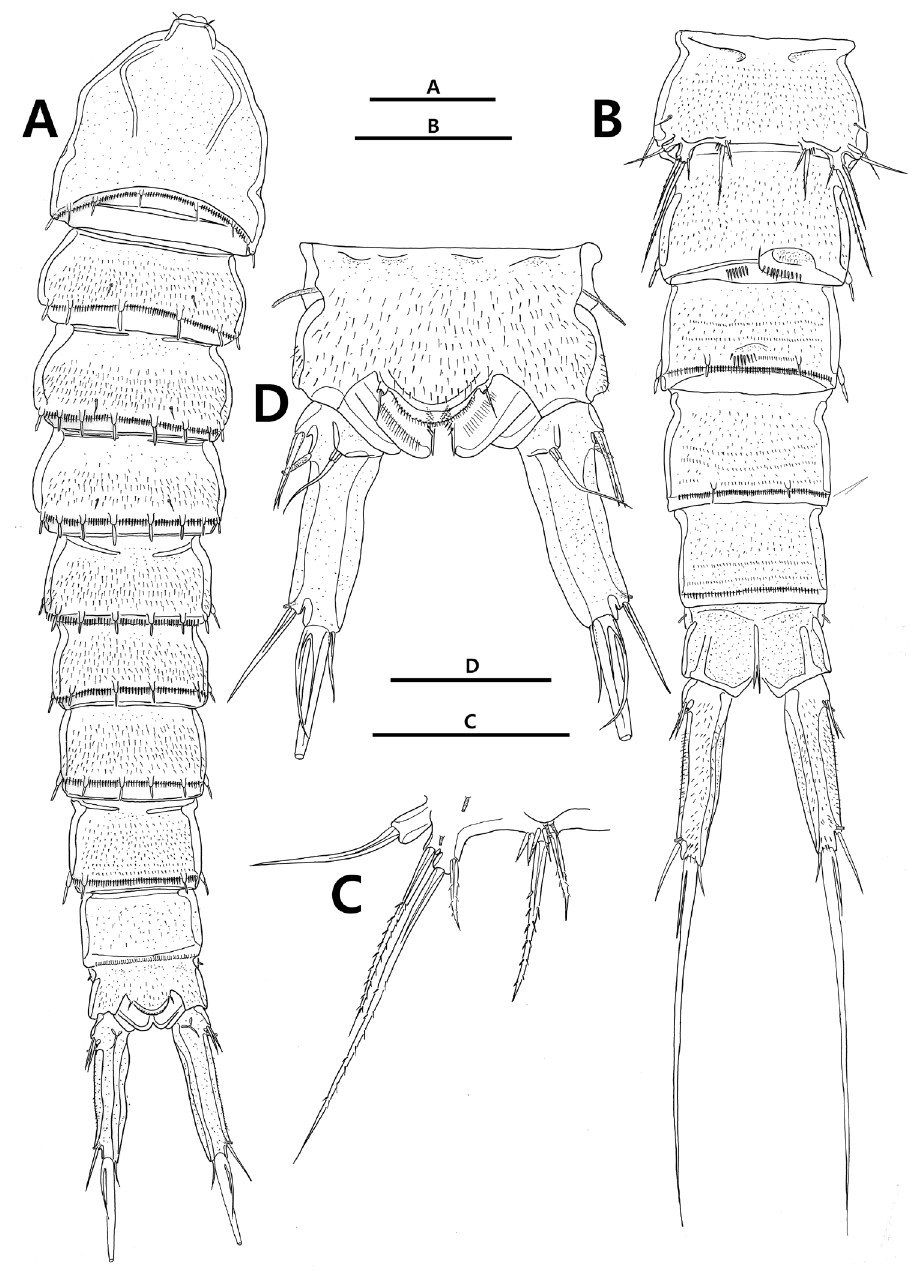
Figure 6. Strongylacron glabrum sp. n. A–C male: A habitus, dorsal B urosome, ventral C P5. D female: D anal somite and caudal rami, dorsal. Scale bars 100 µm ( A, B ), 50 µm ( C, D